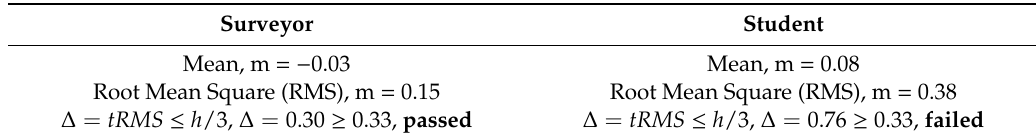
Figure 11. Contours ( a ) and volumetric surfaces ( b ) visual comparison between the reference test area and the student’s data. Table 3. Statistical characteristics.